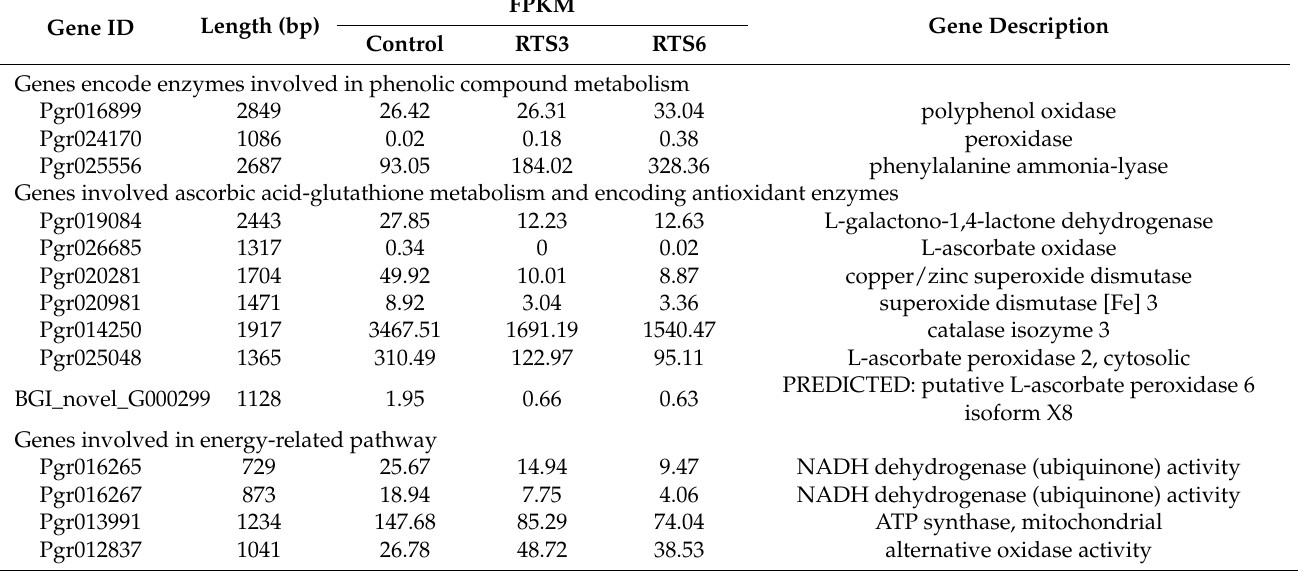
Figure 7. KEGG enrichment of genes only expressed in RTS3 ( A ) and RTS6 ( B ). The X -axis is the number of genes. The Y -axis is the functional classification of KEGG (Kyoto Encyclopedia of Genes and Genomes). Table 2. List of genes potentially related with pericarp browning of